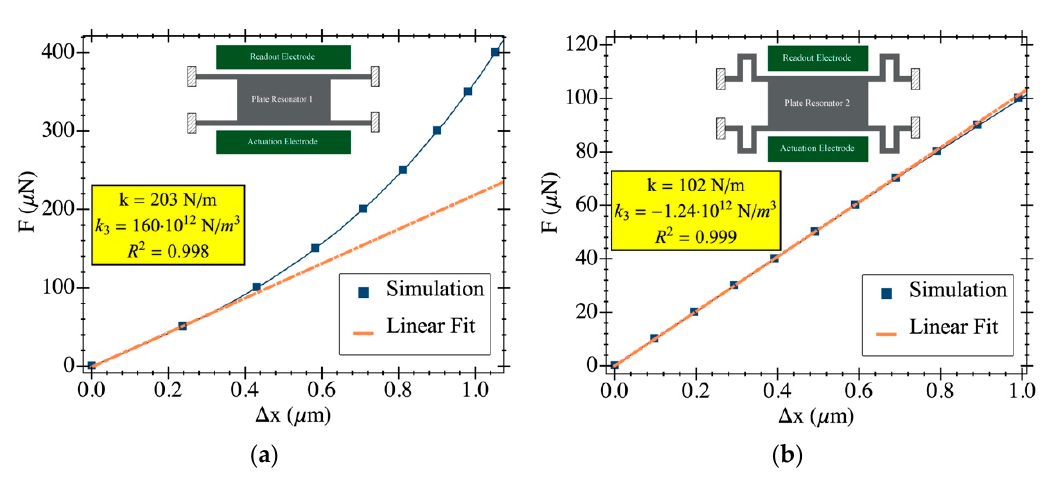
Figure 4. COMSOL Multiphysics simulation results depicting the stiffness constant in the x -axis direction and its non-linear behavior. A lateral force was applied and the resonator displacement determined. The stiffness constant and the non-linear term (k 3 ) are reported in the plots. Additionally, the linear model fit for small vibration amplitude is also included for clarification; the fitting coefficient refers only to this model: ( a ) PR1 shows a deviation from the linear behavior becoming stiffer for larger vibration amplitude; ( b ) PR2 shows no spring-hardening due to the folded flexure anchors that provide free movement along the y -axis.